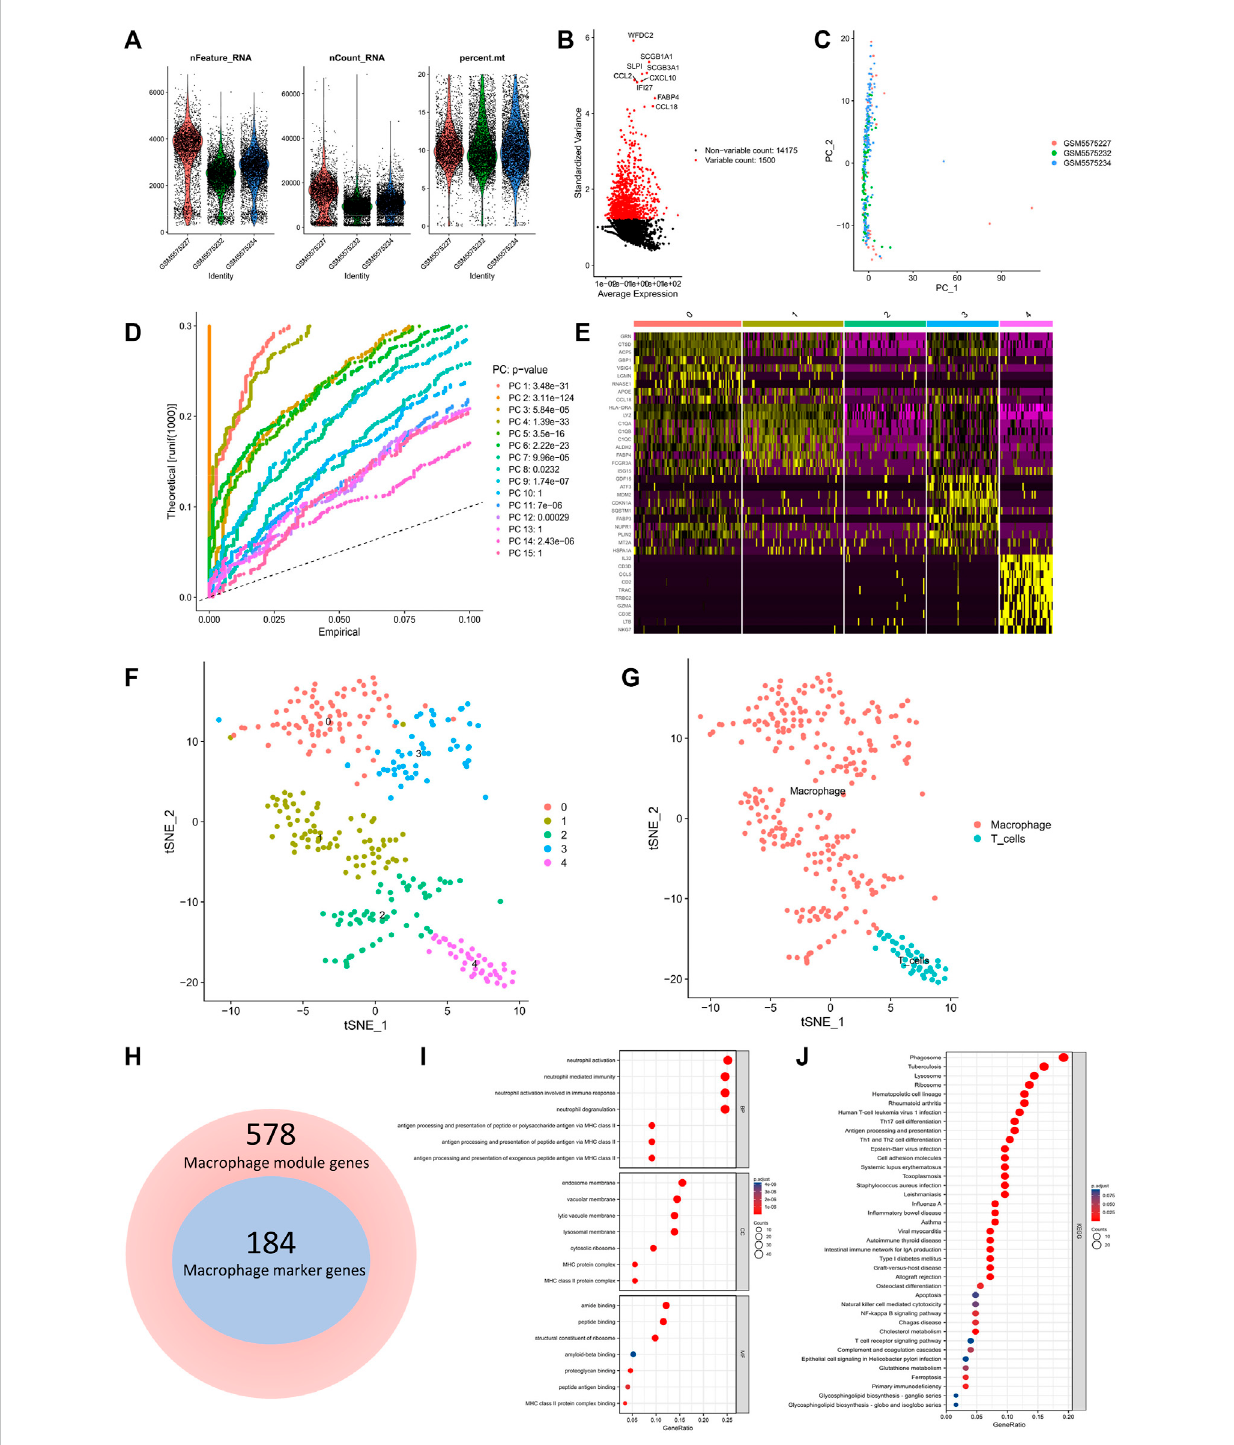
FIGURE 2 Identi fi cation of macrophage cell marker genes by scRNA-seq analysis. (A) Quality control of scRNA-seq data. (B) The variance plot showed 14,175 genes in all cells, red dots represent the top 1500 highly variable genes. (C) PCA was used for dimensionality reduction. (D) 12 PCs were identi fi ed based on p < 0.05 . (E) The heatmap showed the relative expression of genes in 5 clusters. Yellow represents high expressed genes and purple represents low expressed genes. (F) 5 clusters were visualized based on the t-SNE algorithm. (G) Cell subpopulations identi fi ed by marker genes. (H) Venn diagram illustrating macrophage module genes and macrophage marker genes. (I,J) GO and KEGG analysis of macrophage marker